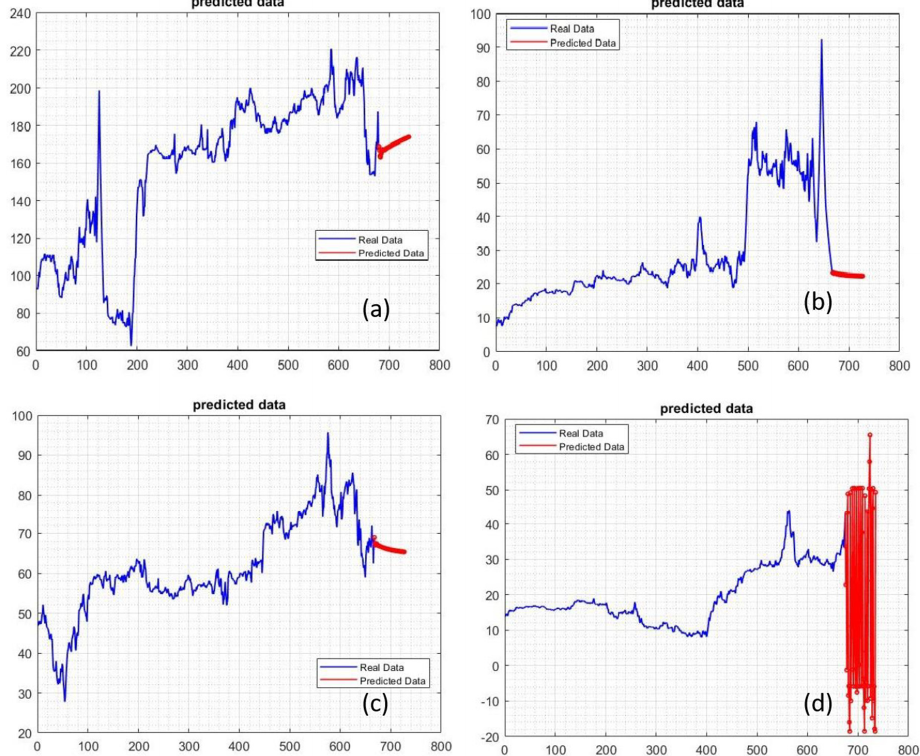
Figure 15. Forecasting values of MLP model, ( a ) communication ( b ) energy, ( c ) financial and ( d ) industrial sectors.